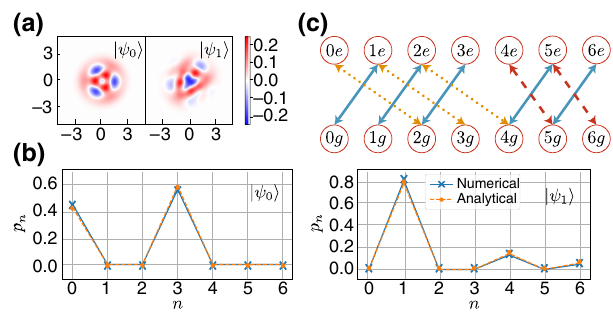
√ FIG. 3. The 3 code. (a) Wigner functions of the two log- ical basis states from AutoQEC . (b) Photon-number distri- √ 3 code agrees well with bution of the analytically derived the numerical result, where | ψ 0 (cid:3) ∈ span {| 0 (cid:3) , | 3 (cid:3)} and | ψ 1 (cid:3) ∈ span {| 1 (cid:3) , | 4 (cid:3) , | 6 (cid:3)} . (c) Required Hamiltonian couplings for autonomously protecting the code.